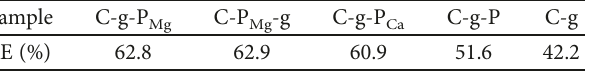
, (b) C-P -g, and (c) C-g-P . Mg Mg Ca Table 1: Encapsulation e ffi ciencies (%) of curcumin-loaded chitosan-pectin